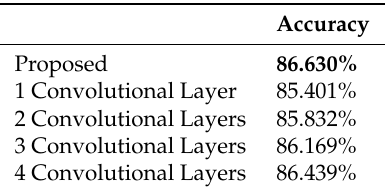
Table 3. The effect of the convolutional layers.